Question: Give a one-sentence summary of this figure.
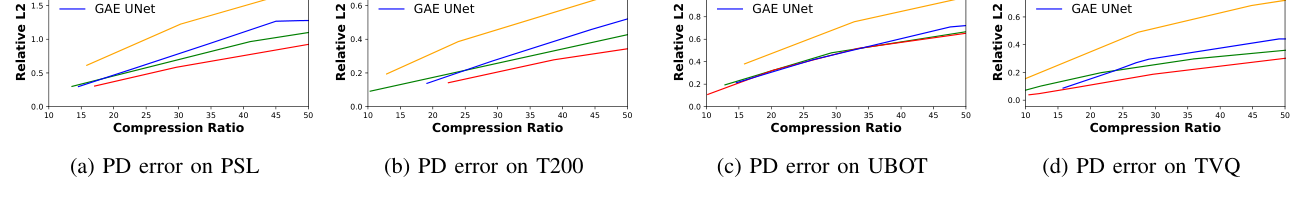
Answer: Comparison of PD error for four variables using the four methods described in the paper. The other three variables have similar relative behavior for the four methods. Overall, GAE-based approaches provide higher compression than other methods for the same error levels and comparable QoI. The QoI are for a subset of these variables, presented in Figure 5.